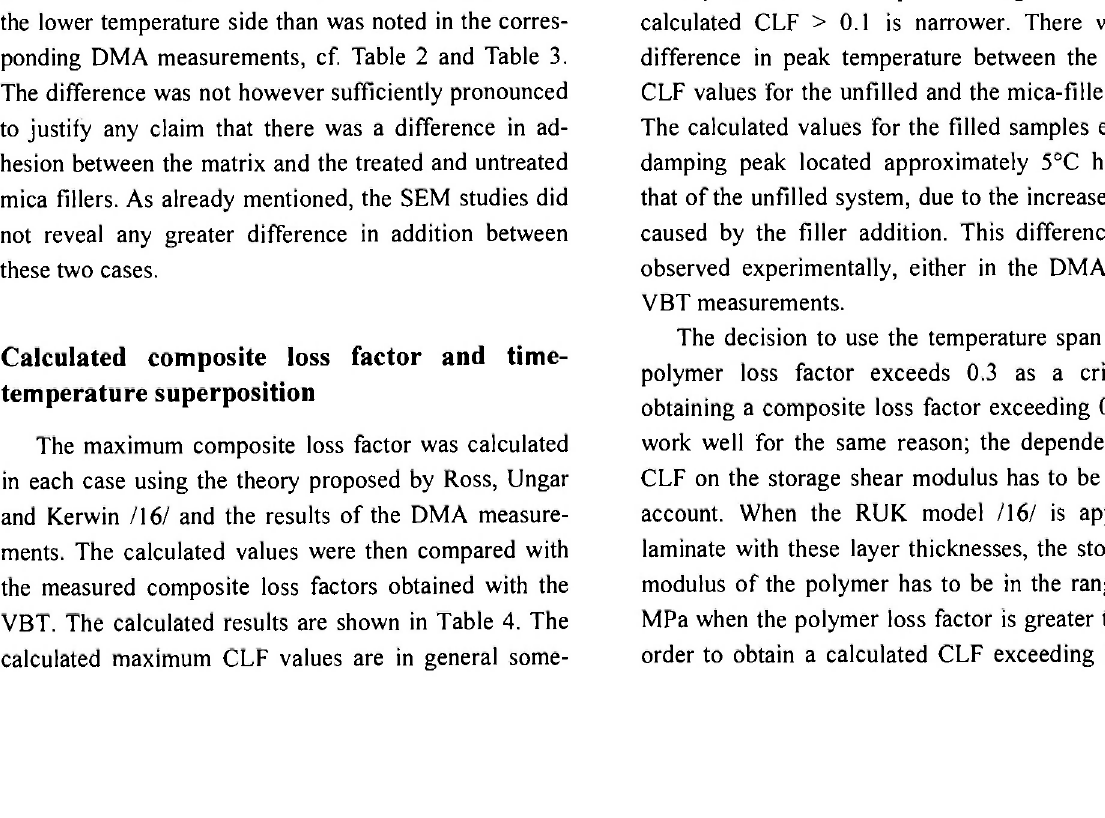
Fig. 8: Effect of the amount of Mica 200 on the laminate damping properties. VBT-measured composite loss factor as a function of temperature, 2 nd vibration